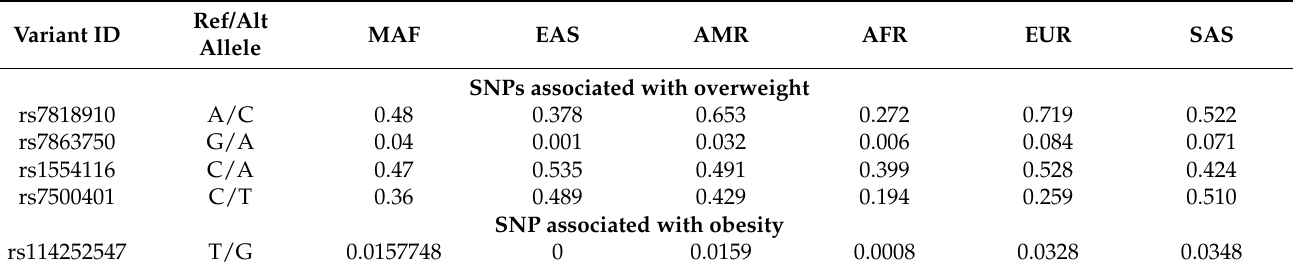
Table 3. Allele frequencies in five populations for the SNPs found to be associated with overweight and obesity; Ref/Alt, reference/altered; MAF, minor-allele frequency; EAS, East Asian; AMR, Ameri- can; AFR, African; EUR, European; SAS, South